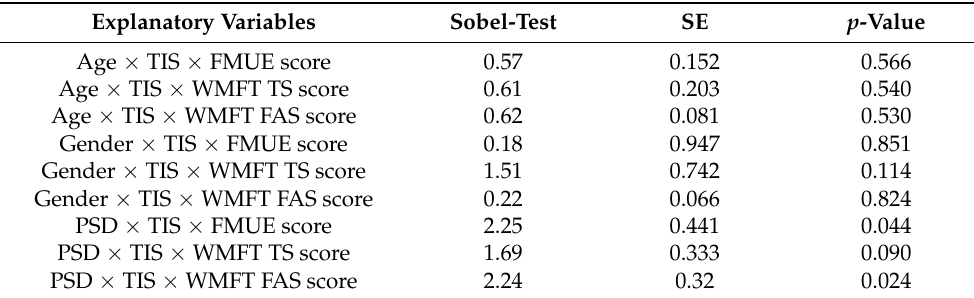
Table 3. Sobel test for the indirect effect for statistical